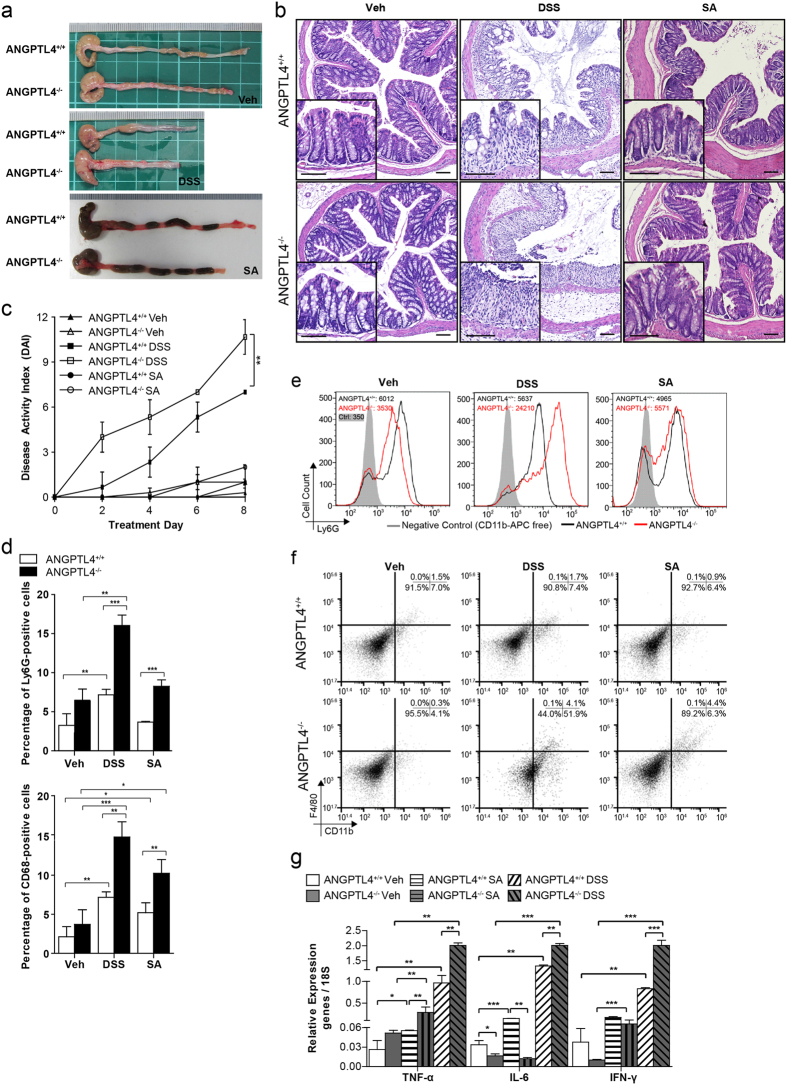
ANGPTL4 attenuates colonic inflammation.(a–e) Images of colon samples (a) Representative colon sections stained with hematoxylin and eosin (H&E) (b). (c) Disease activity index (DAI) of mice assessed every alternate day over the treatment regimes. Scoring criteria can be found in Supplementary Table S1. (d) Percentage of Ly6G+ and CD68+ cells per field of view. Total DAPI-stained nuclei were taken as the total cell number. Microscopic views from 5 different sections were numerated. (e) Representative FACS histograms for Ly6G expression (neutrophils) from ANGPTL4+/+ and ANGPTL4−/− littermates for the indicated treatments. (f) Representative FACS analysis of the colons from ANGPTL4+/+ and ANGPTL4−/− mice double stained for F4/80 (macrophages) and CD11b (macrophages, monocytes, granulocytes, NK cells, dendritic cells) for each of the treatments. (g) Relative mRNA levels of pro-inflammatory cytokines (TNF-α, IL-6 and IFN-γ) from ANGPTL4+/+ and ANGPTL4−/− mice at the endpoint. For the Veh, DSS and SA groups, n = 20 mice were used for each treatment. The Mann–Whitney U test was used. *p < 0.05; **p < 0.01.